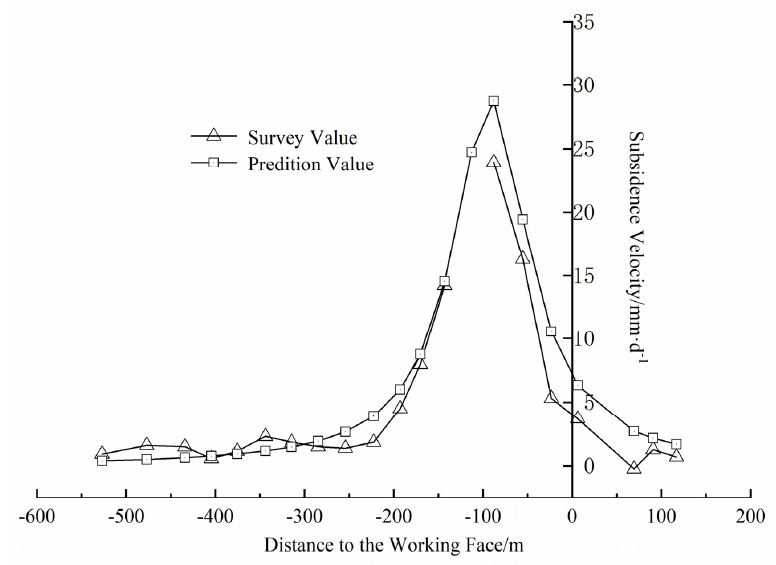
values, as shown in Figure 13.